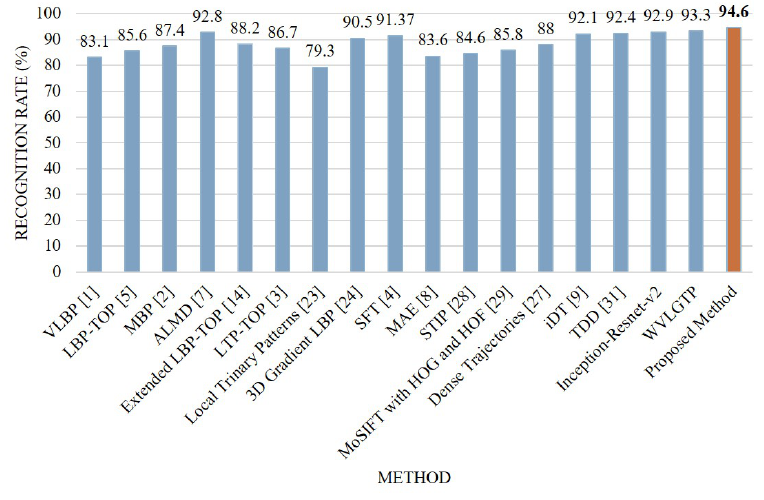
Figure 11. Comparison between the proposed method and other state-of-the-art approaches on the UCF sports action